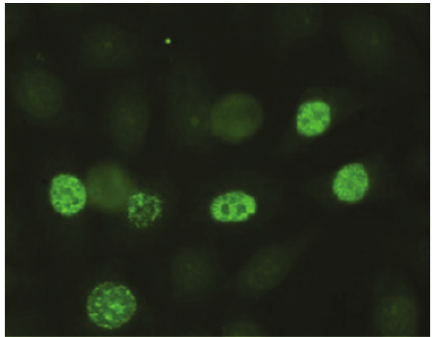
Figure 4: IIF on Hep2 cells: speckled pattern of varying intensity (anti-PCNA antibodies). Diluition 1: